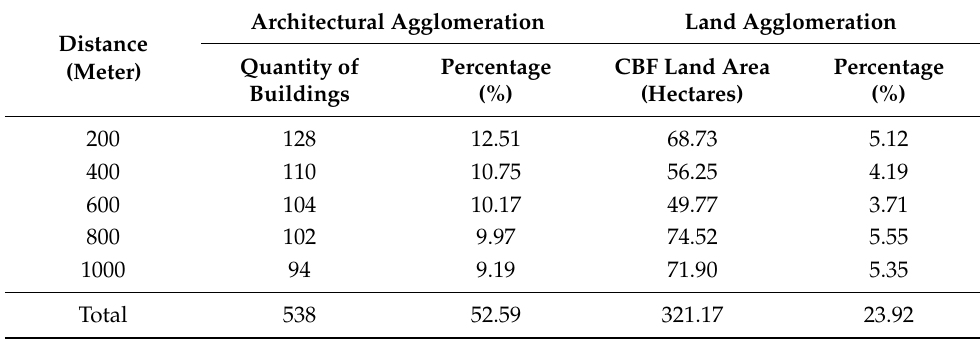
Table 3. Spatial agglomeration of expressway in the inner fringe.